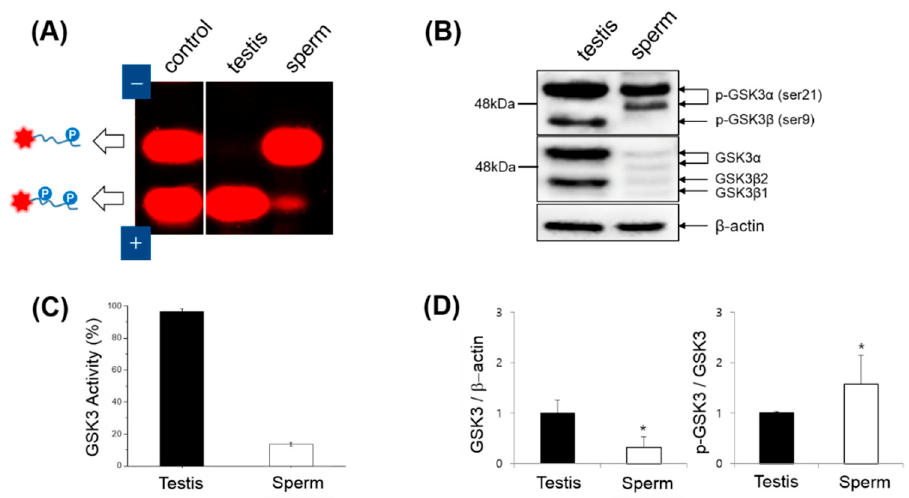
Figure 4. ( A ) Fluorescent gel shift assay of GSK3 activity in mouse testis and sperm extracts. T-Pep(p) was used to assay endogenous GSK3 activity after being mixed with testis or sperm extract at the same total protein concentration. ( B ) Western blots developed with anti-phosphoserine (Ser9/Ser21 in GSK3) antibody (Top) and anti-GSK3 α / β antibody (Middle) in the testis and sperm extracts. The control anti- β -actin antibody (Bottom) was used as a control to ensure equal protein loading. The relative GSK activity (%) ( C ), GSK expression (GSK3/ β -actin, left graph in ( D )), and GSK inhibition (p-GSK3/GSK3, right graph in ( D )) were analyzed from ( A , B ). The standard deviations in ( C , D ) were obtained from three independent experiments.